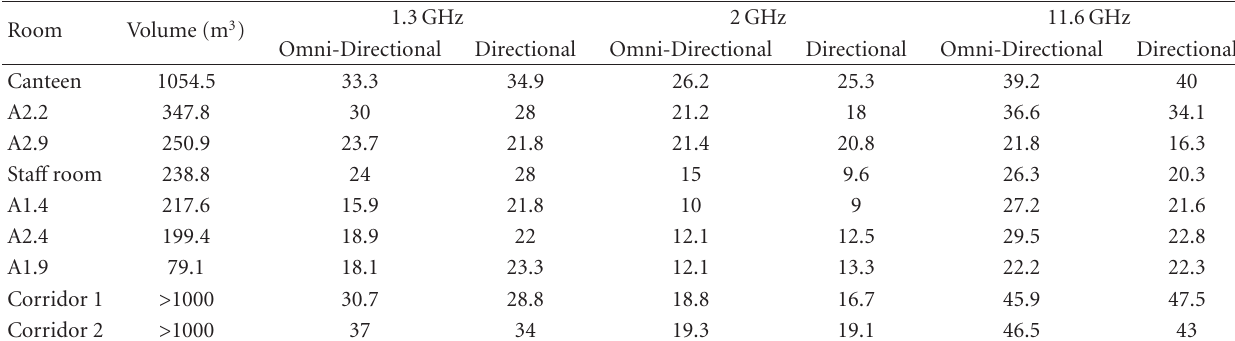
Table 5: Mean RMS delay spread (ns) in di ff erent indoor